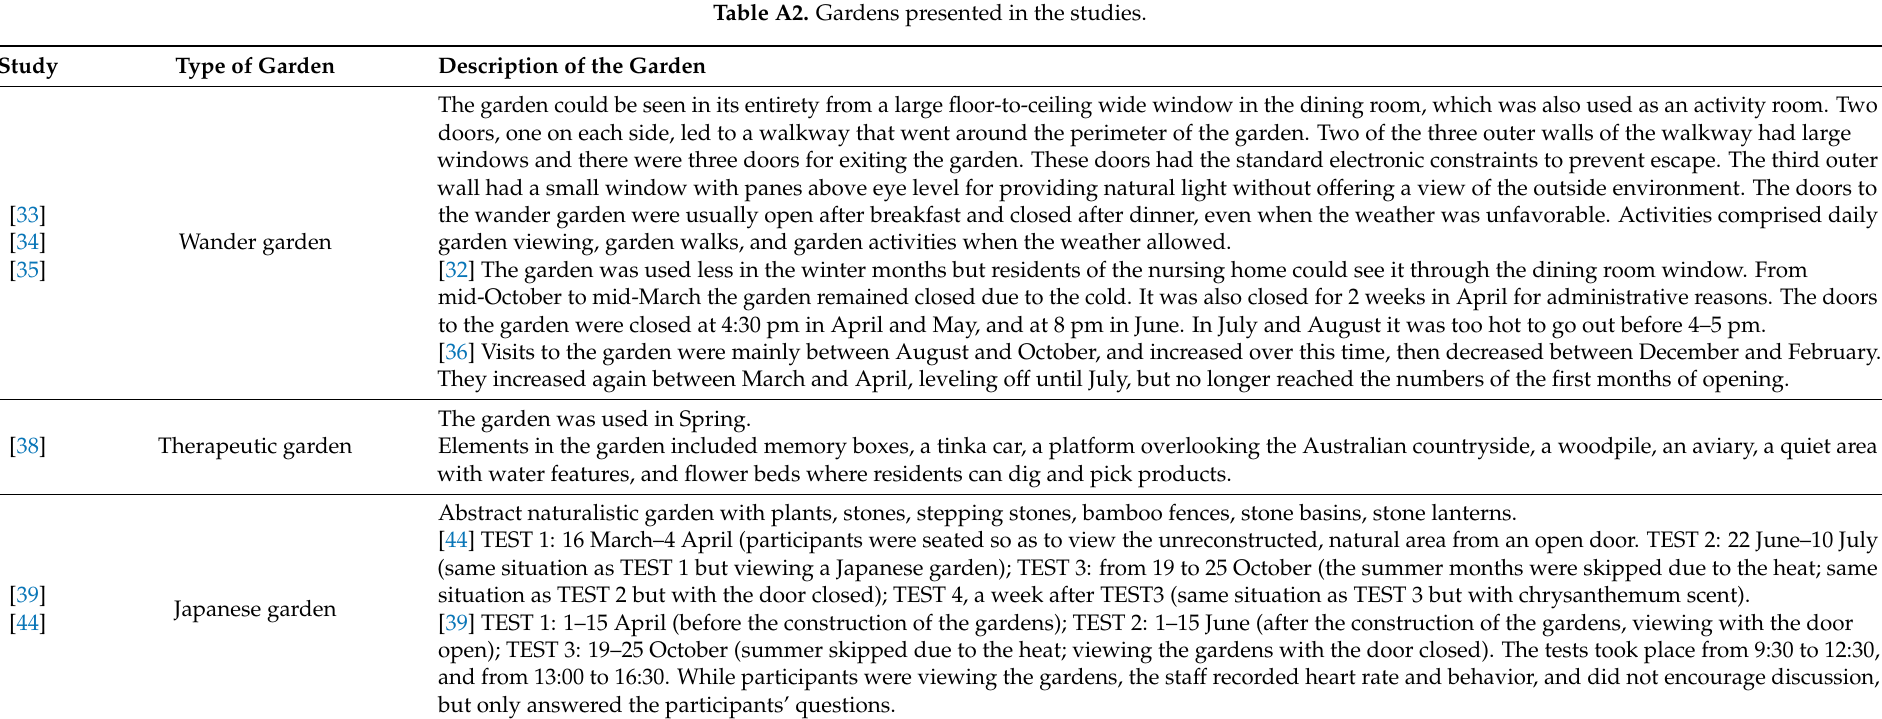
Table A2. Gardens presented in the